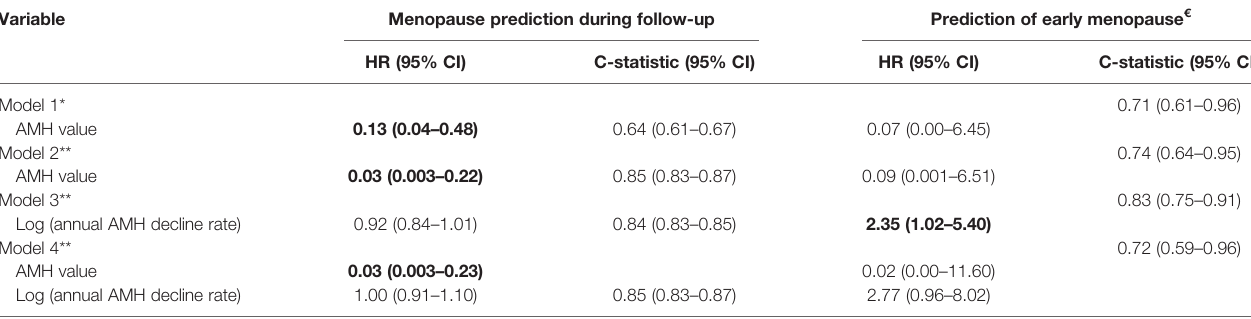
TABLE 3 | Summary statistics for the time-dependent Cox regression approach for prediction of menopause/early menopause according to single/repeated AMH measurements. Variable